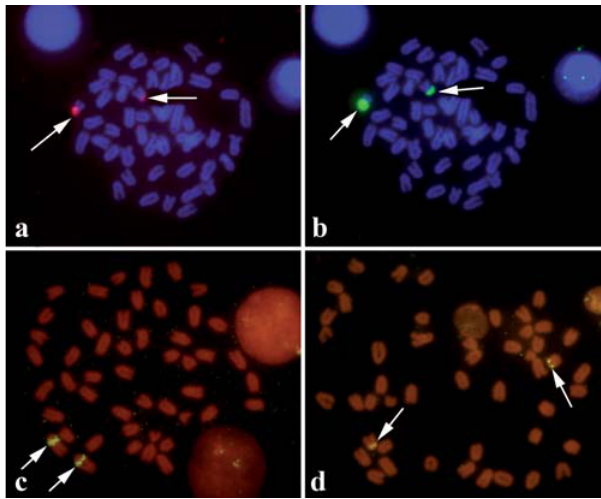
Fig. 4. Metaphases of Rhomboplites aurorubens (a-b) and Ocyurus chrysurus (c-d) after FISH with 18S rDNA (left) and with 5S rDNA (right). Arrows indicate the NOR bearing chromosomes. Arrowheads indicate the 5S rDNA bearing